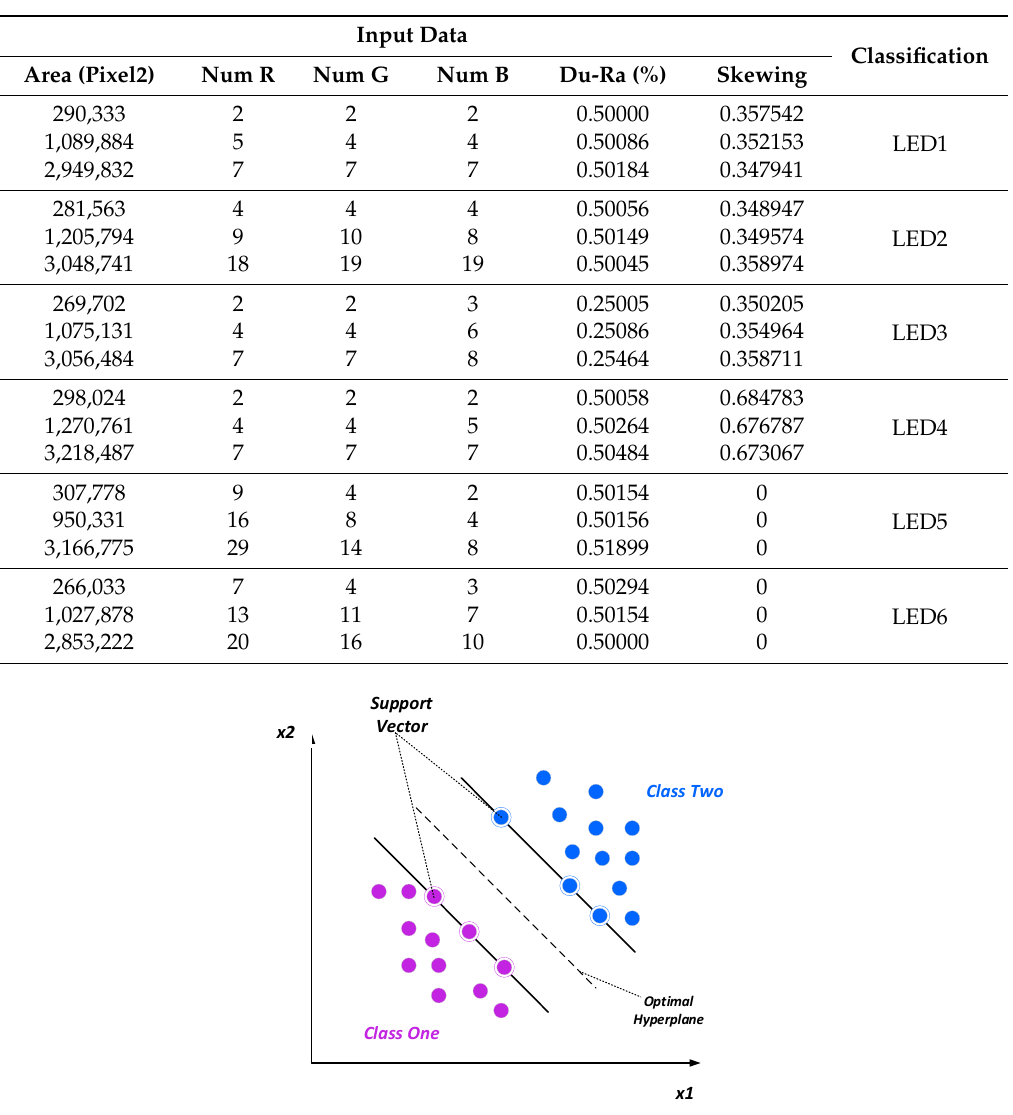
Table 1. Part of the input data and classification.